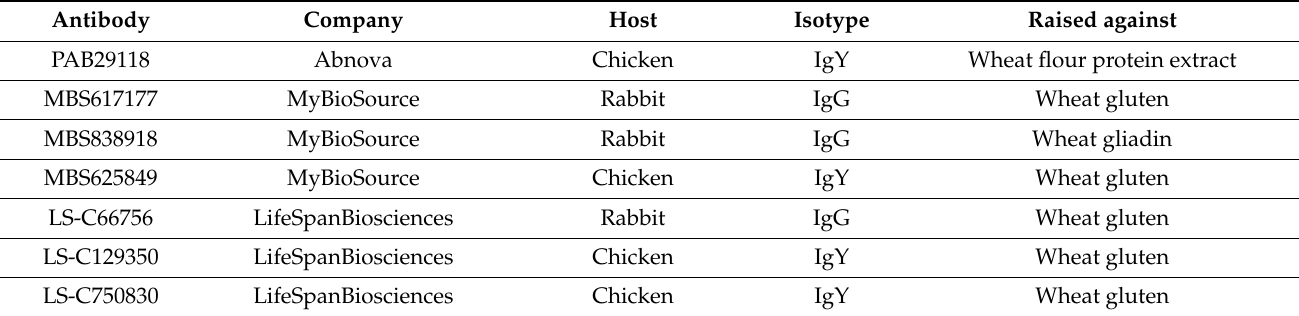
Table 2. Some examples of polyclonal antibodies against gluten or its fragments.